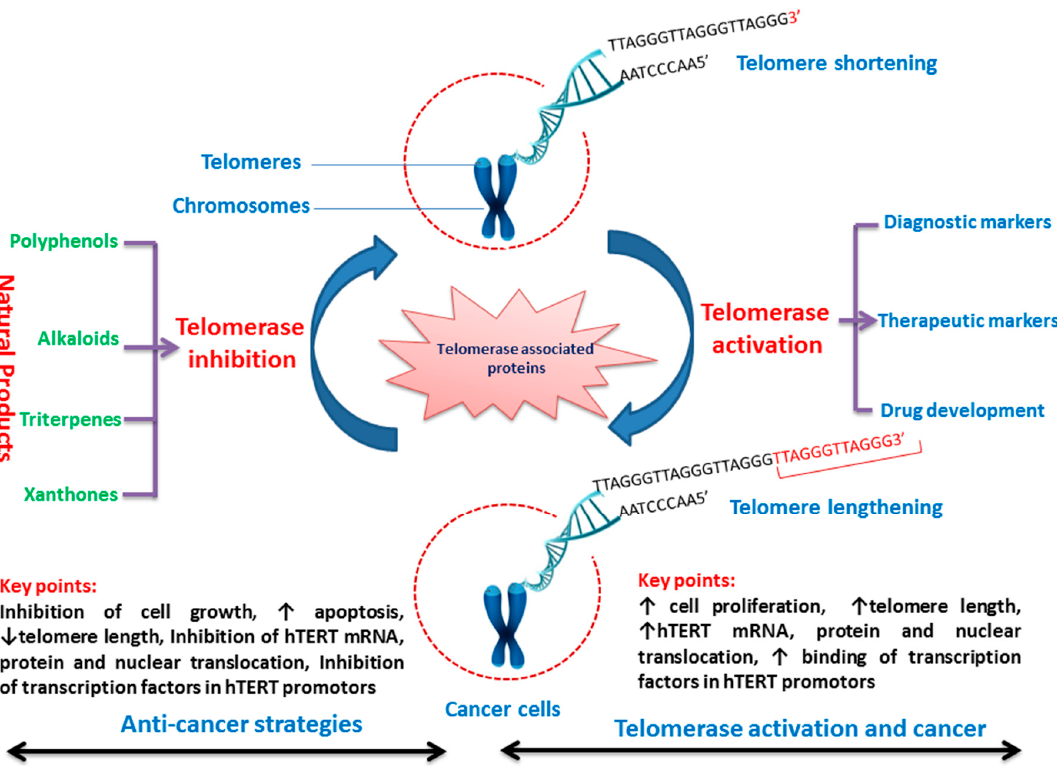
Figure 1. Telomerase-related anticancer strategies by natural products. ↑ : increase; ↓ : decrease; hTERT: human telomerase reverse transcriptase.